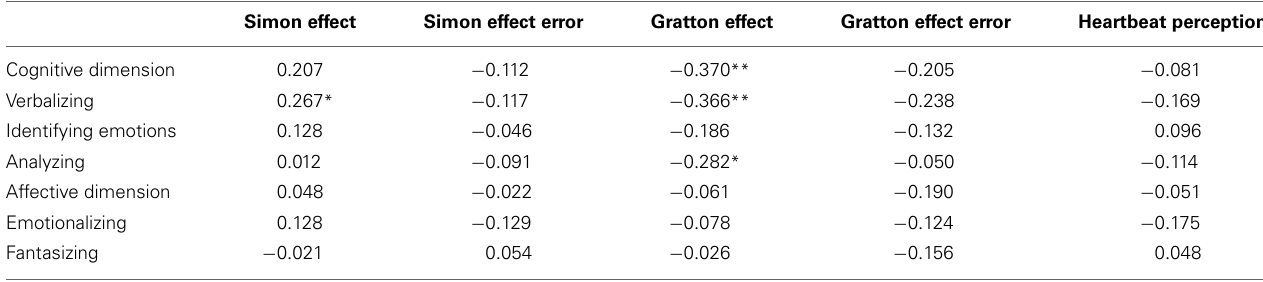
Table 1 | Correlations between the two BVAQ dimensions (and their respective subscales) and the heartbeat-detection score, the Simon and Gratton effects (in terms of RTs and